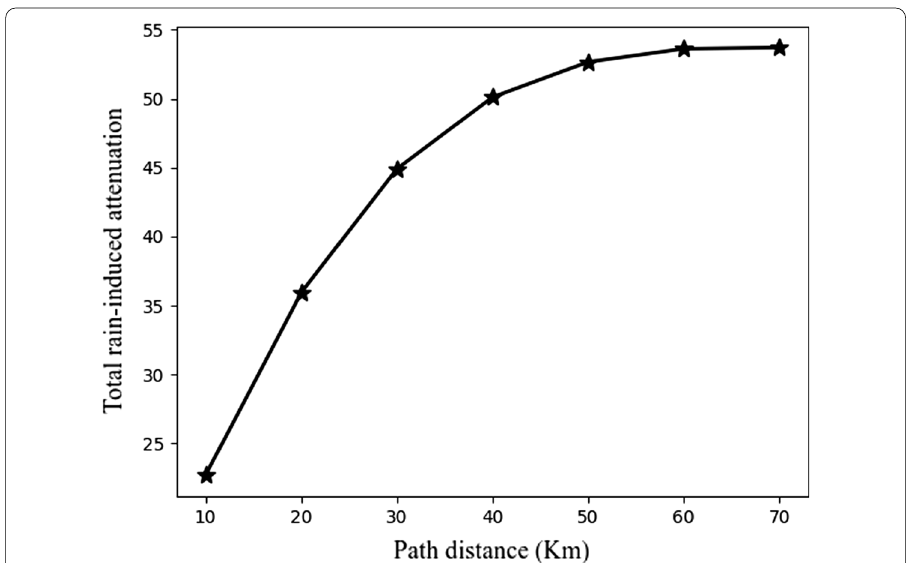
Fig. 9 Path distance versus Rain Attenuation at rain rate R 0.01 and frequency of operation 11-GHz. This graph shows the relationship between path distance and total rain induced attenuation at a rain rate of exceedance R 0.01 for a particular frequency of operation 11 GHz